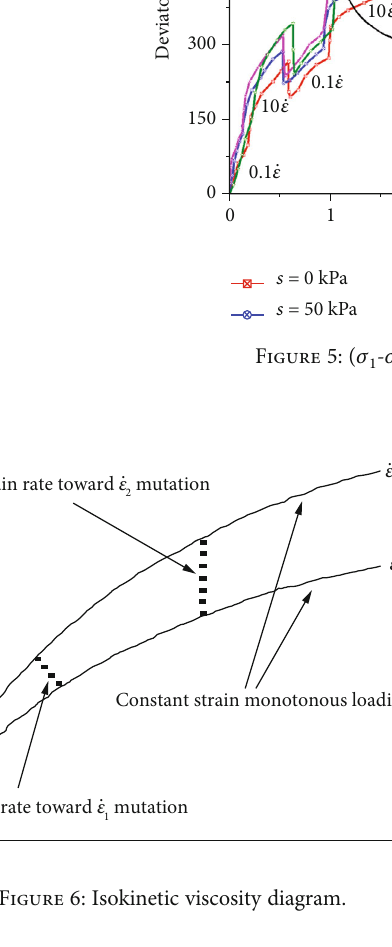
Figure 6: Isokinetic viscosity